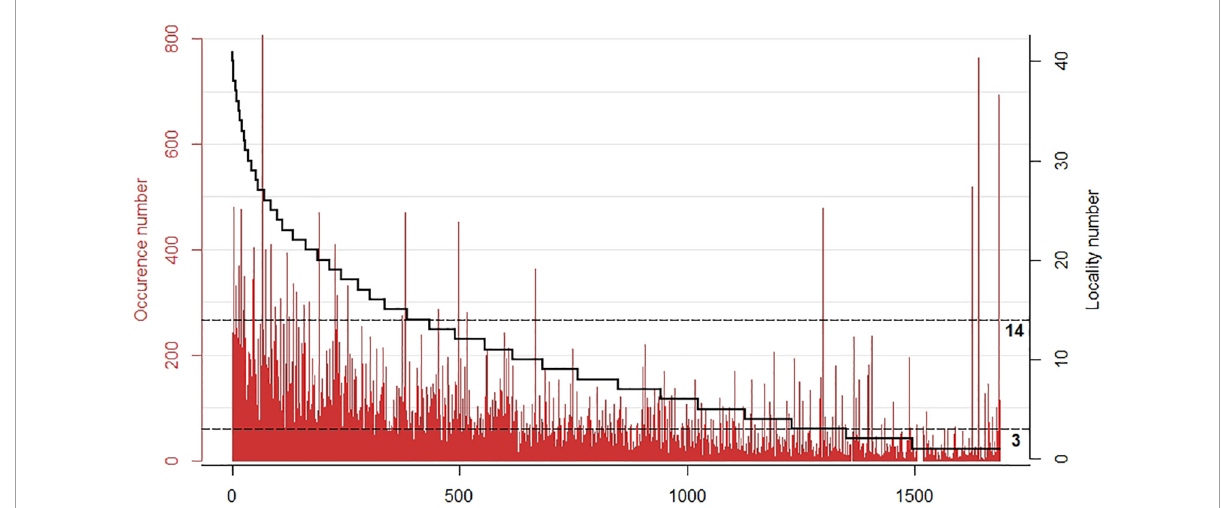
FIGURE3 Overview of the commonness and rarity of the studied flora. Each column represents the number of occurrences of a taxon in the dataset (left y-axis) and the black curve represents the corresponding locality number (right y-axis). X-axis gives a scale of taxa number. The dashed-lines represent the first (3) and third quartiles (14) of the locality